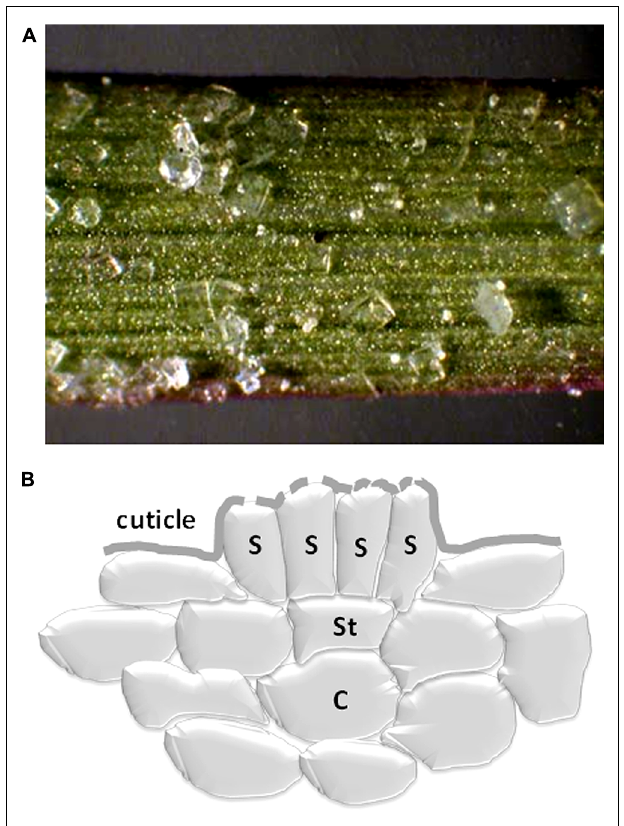
FIGURE 4 | (A) Distichlis spicata salt extrusion via multiple glands on its leaves. Note the formation of salt crystals (courtesy of Justin Klitzes, http://www.mbari.org/staff/conn/botany/seagrass/justin/salt_extrusion.htm). (B) Schematic diagram of a salt gland showing a collective cell (C), a stalk cell (St) and secretory cells (S). A cuticle is present with perforations to allow the excreted salt to exit the symplast.